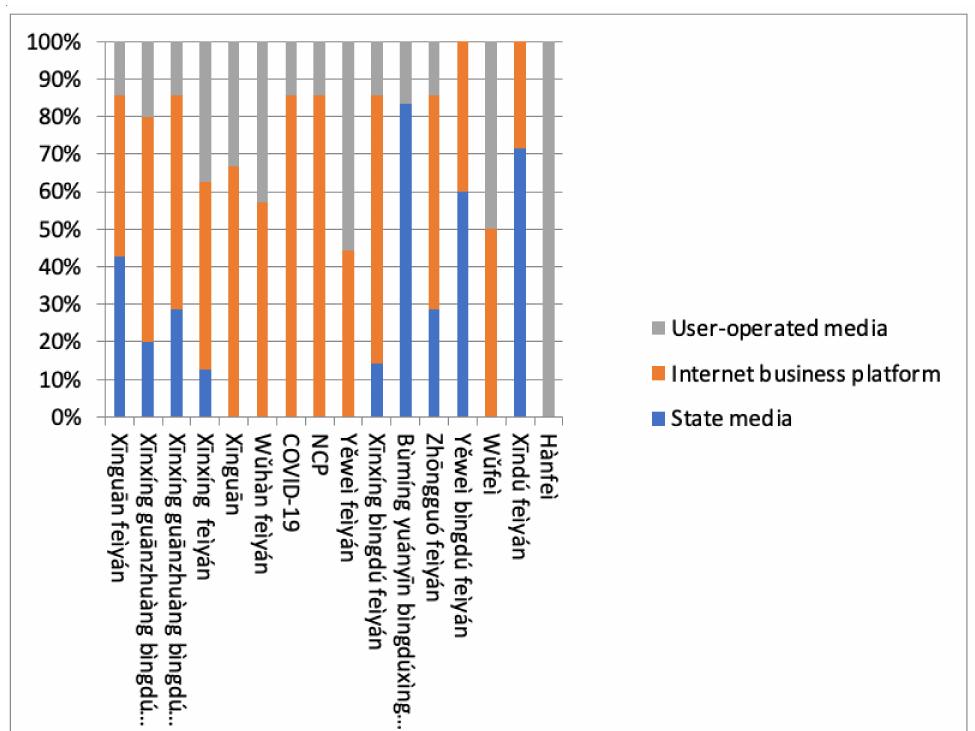
Figure 1. Frequency distribution of names across active